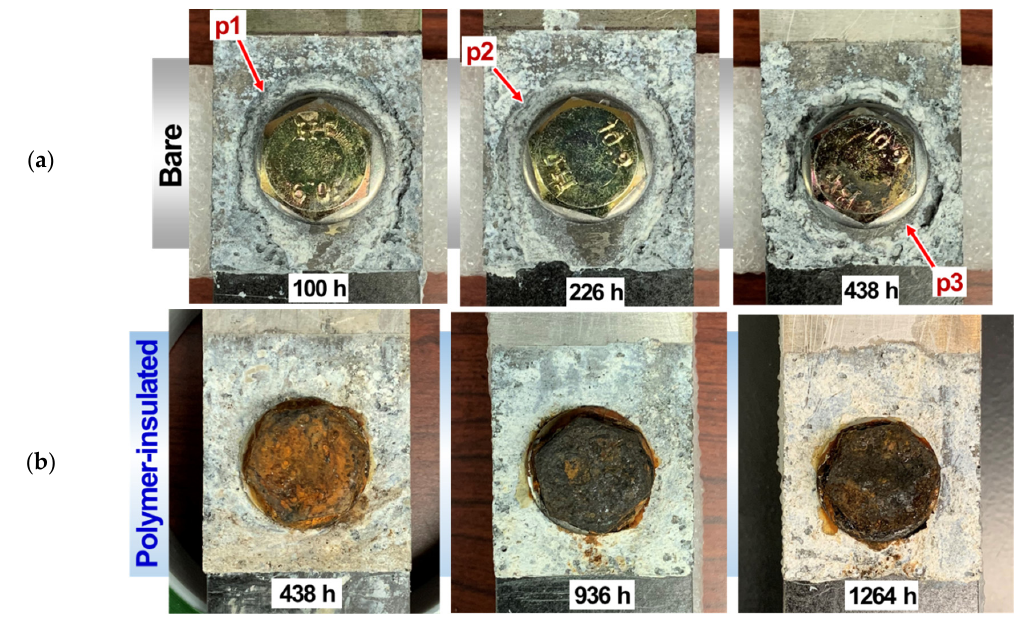
Figure 6. Lap shear bolted joints after salt spray exposure presented for ( a ) bare and ( b ) polymer-insulated conditions. The exposure time is designated for each specimen.